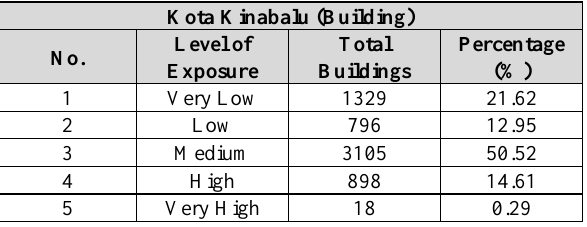
Table 9. Level of building exposure toward hazard in Kota Kinabalu